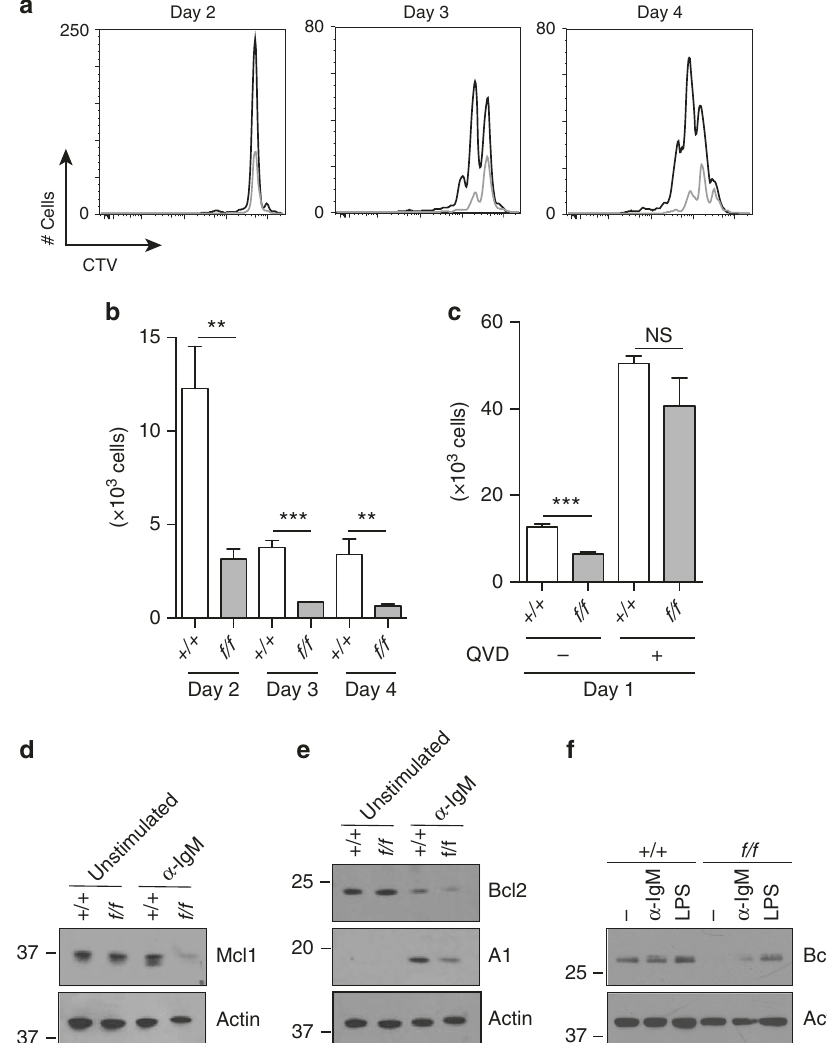
Fig. 7 Prmt1 -de fi cient B cells respond abnormally to in vitro stimulation. a , b Splenic B cells, puri fi ed from control ( + / + ) and Prmt1 f/f CD23Cre ( f/f ) mice, were labelled with CTV and cultured in the presence of F(ab ′ ) 2 anti-IgM antibody for the indicated times. a Overlay histograms show division pro fi les of live cells at days 2, 3 and 4 of activation for control (black line) and Prmt1 -de fi cient (grey line) B cells. b Quanti fi cation of live cells at time points indicated after stimulation for control ( + / + ) and Prmt1 -de fi cient ( f/f ) samples. c Control ( + / + ) and Prmt1 -de fi cient B cells ( f/f ) were activated with F(ab ′ ) 2 anti-IgM antibody for 24 h in the presence or absence of the broad caspase inhibitor, QVD. Viable cell numbers are indicated. b , c ** P ≤ 0.01; *** P ≤ 0.001; ns = not signi fi cant (unpaired t -test). Data are representative of three experiments with three replicates per experiment. Mean and s.e.m. d – f Defective regulation of MCL1, BCL2, A1 and BCLX in activated Prmt1 -de fi cient B cells. Immunoblot analysis of spleen B cells from control ( + / + ) and Prmt1 f / f CD23Cre ( f/f ) mice. d , e B cells were unstimulated or activated for 24 h with F(ab ′ ) 2 anti-IgM, then lysed and separated by SDS-PAGE. d MCL1 and e BCL2 and A1 protein amounts were detected with the respective antibodies. f Control (+/+) and Prmt1 f/f CD23Cre ( f/f ) spleen B cells were unstimulated ( − ), activated with F(ab ′ ) 2 anti- IgM ( α -IgM) or LPS for 24 h, then lysed and separated by SDS-PAGE. BCLX protein was detected by speci fi c antibody as indicated. d – f Actin was used as a loading control and comparable results were obtained in three independent experiments. Uncropped images of blots are presented in Supplementary Fig. 5. Flow cytometry gating strategies for this fi gure are shown in Supplementary Fig.